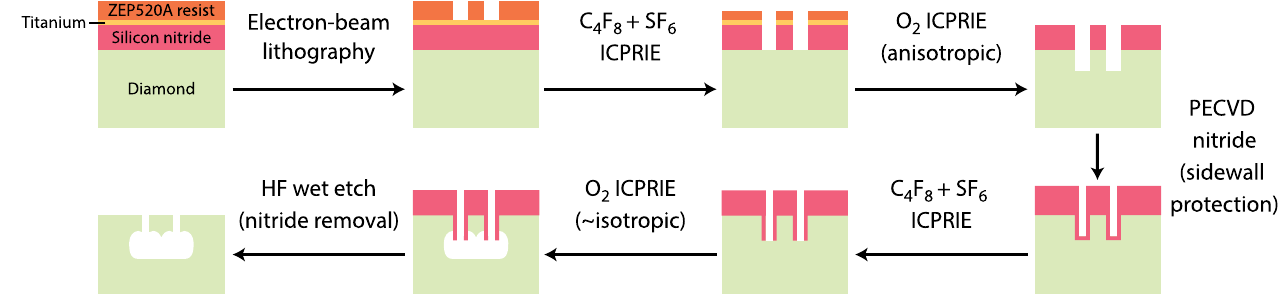
FIG. 2. Process flow for creating diamond nanobeams using quasi-isotropic reactive-ion undercut